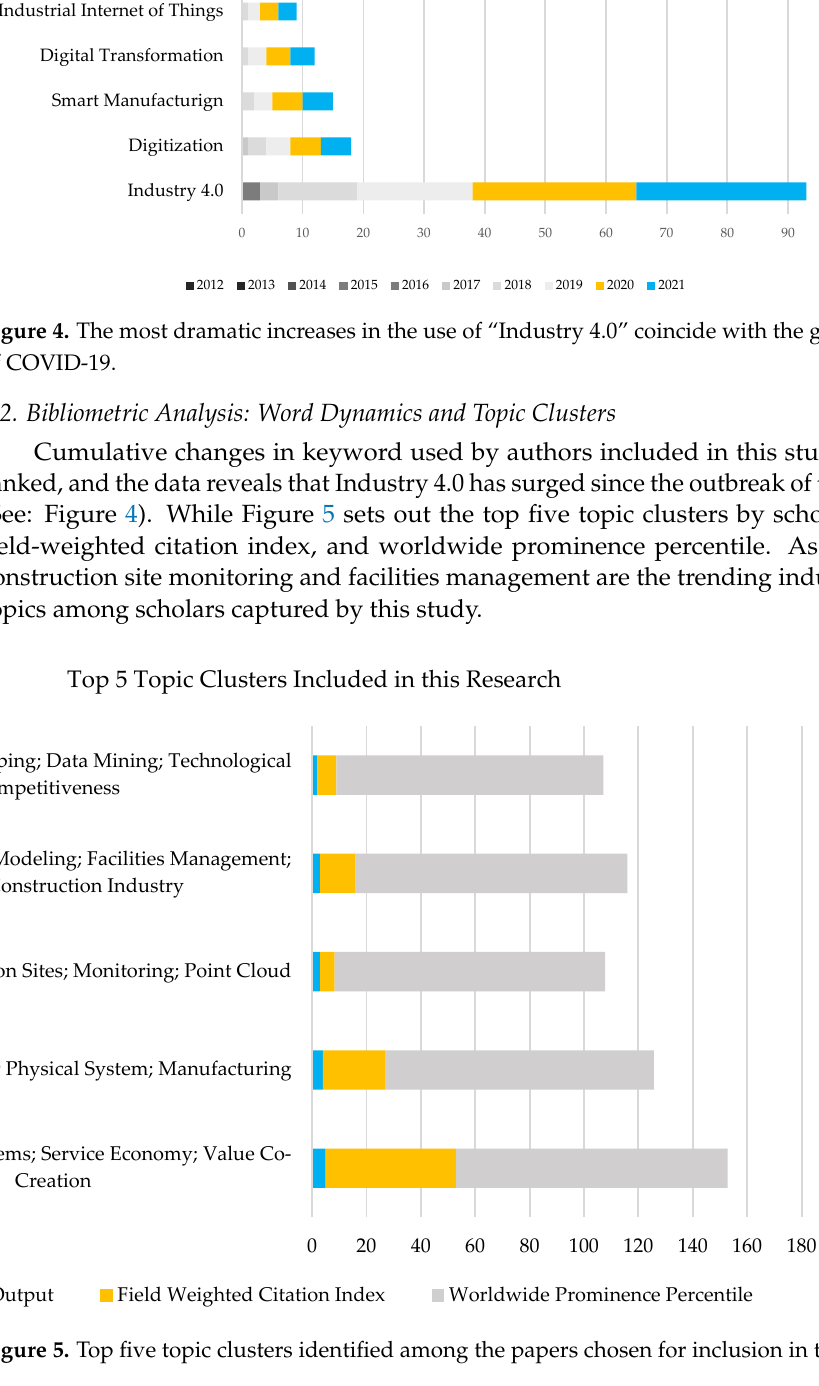
Figure 5. Top five topic clusters identified among the papers chosen for inclusion in this research.